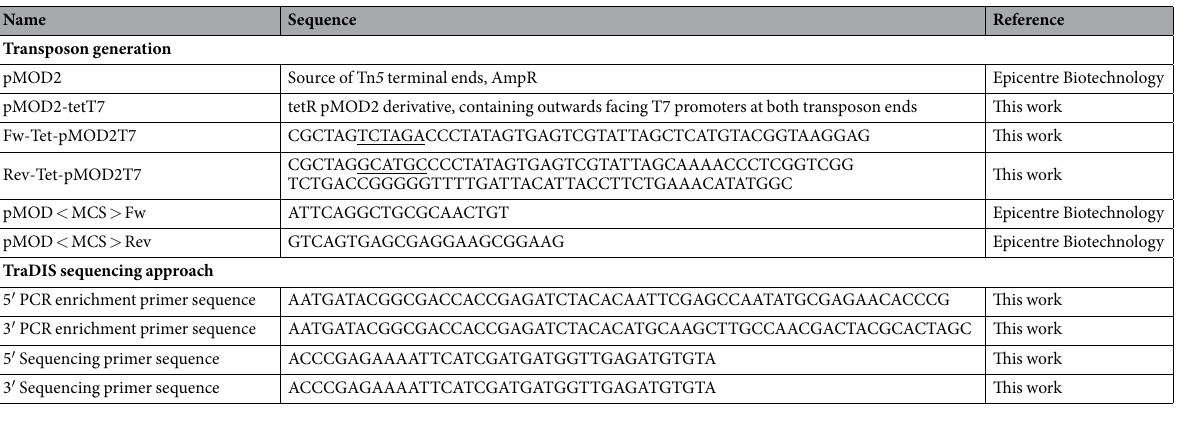
Table 2. Oligonucleotides and plasmids used in this work. a Restriction sites are